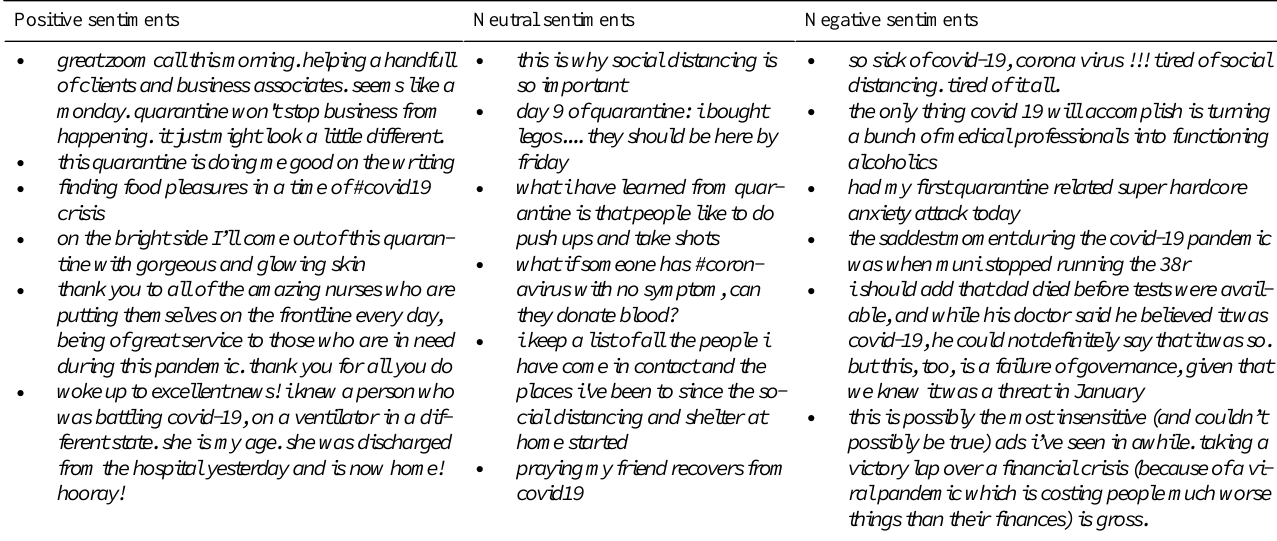
Table 3. Examples of tweets expressing positive, neutral, and negative sentiments about coronavirus disease (COVID-19).